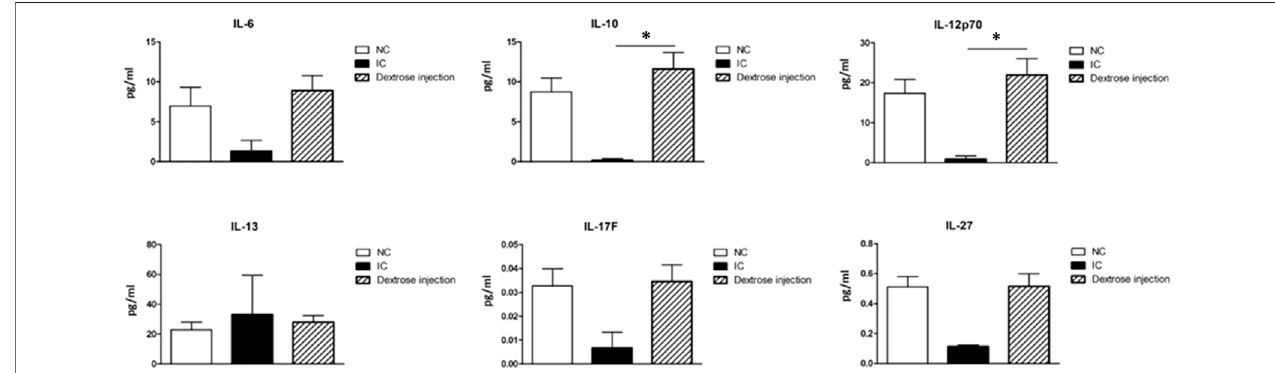
FIGURE11| Comparison ofserum concentrationsofcytokine(IL-6, IL-10,IL-12p70, IL-13,IL-17F,and IL-27)betweenhealthycontrols(NC) andIC/BPSpatients before and after dextrose prolotherapy. * p ≤ 0.05 was considered signi fi